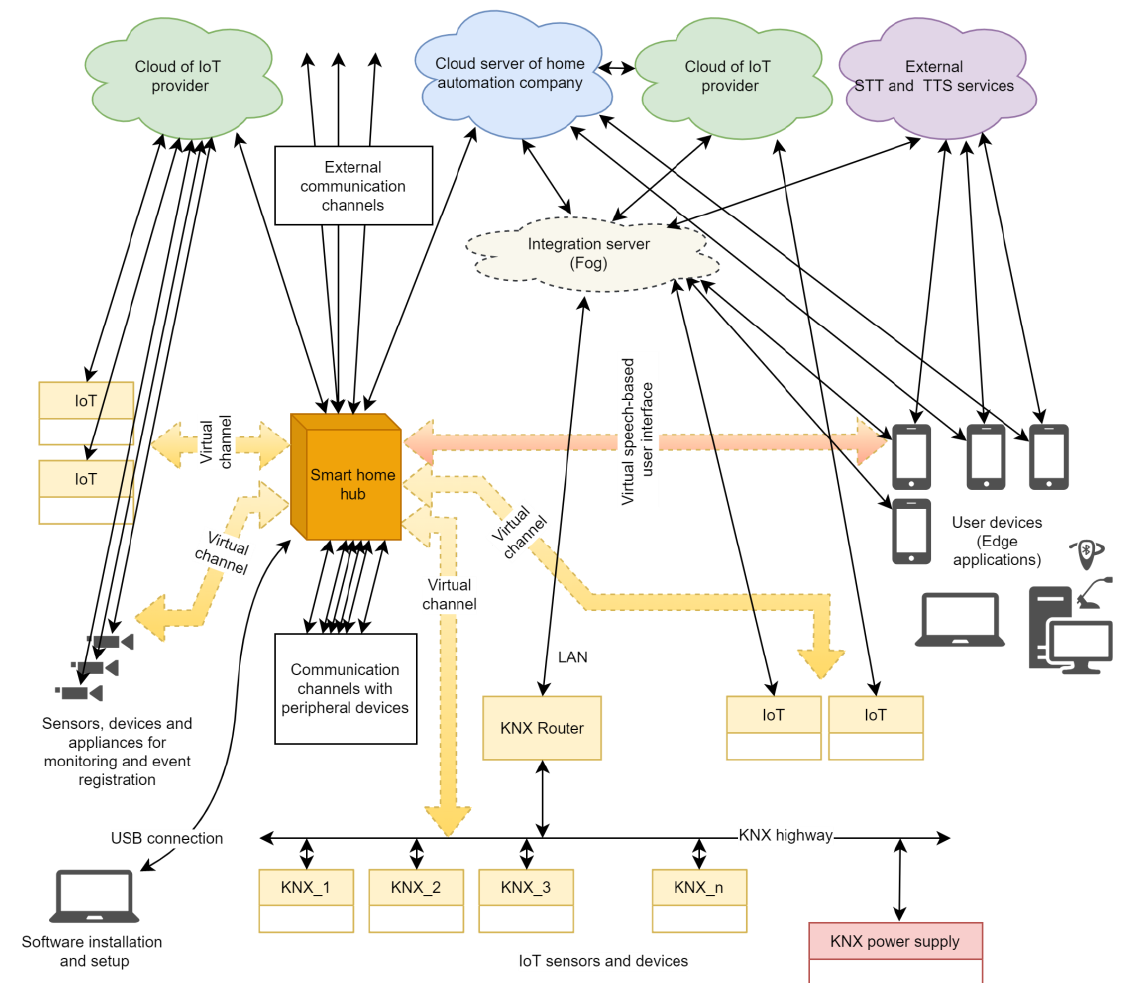
Figure 1. Framework for voice-based user interface. Note: Black arrows indicate direct communica- tions between central panel (hub) and system’s elements, while yellow arrows show indirect ones. The indirect communications consist of multiple requests to services.